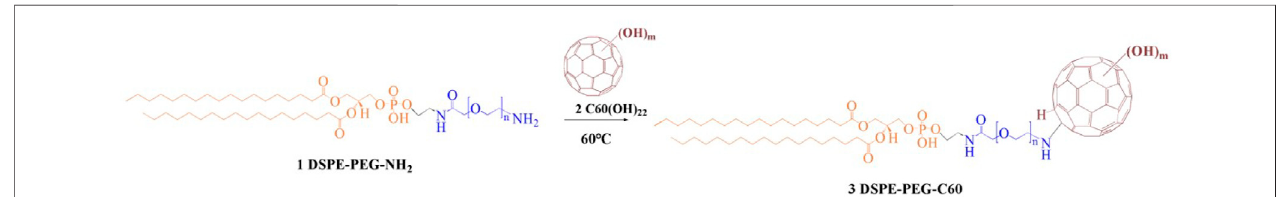
FIGURE 1 | Synthesis of